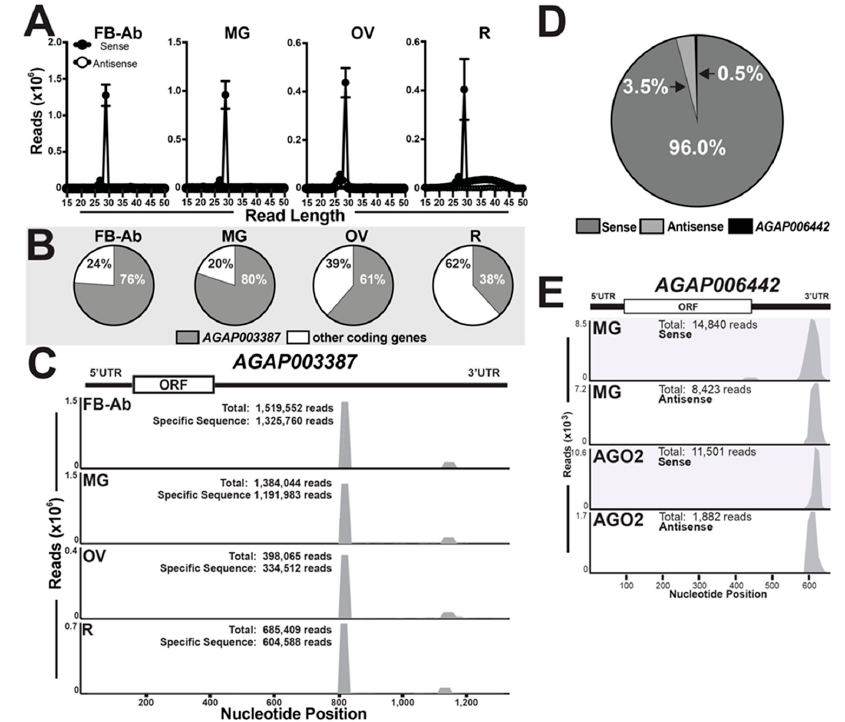
Figure 5. mRNA-derived small RNAs across tissues. ( A ) Nucleotide size distribution histograms of sense and antisense mRNA-derived small ncRNAs across mosquito tissue groups, fat body abdominal wall (FB-Ab), midgut (MG), ovary (OV), and remaining head and thorax tissues (R). Values graphed as the average +/ − SEM from three biological replicates. ( B ) Percentage of mRNA-derived small ncRNAs mapping to AGAP003387 and other coding genes across tissues. ( C ) AGAP003387 -derived small ncRNAs mapping to 3 ′ UTR across mosquito tissues. ‘Total’ refers to the number of reads mapped to the transcript, and ‘specific sequence’ refers to the number of reads mapped to a specific 29-nt sequence. A representative for AGAP003387 -derived small ncRNAs is